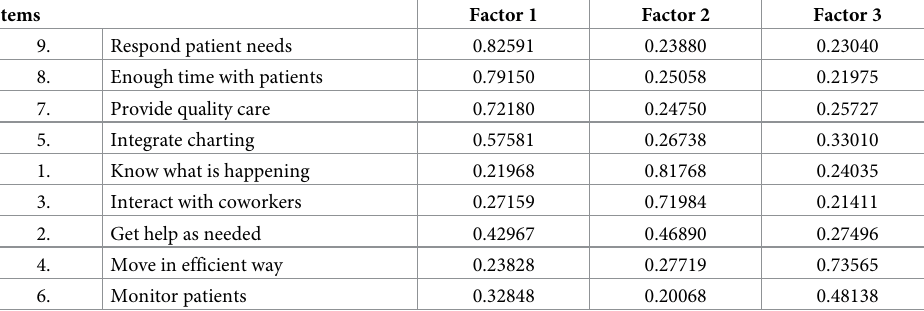
Table 13. Phase 4 varimax rotated three-factor model loadings.